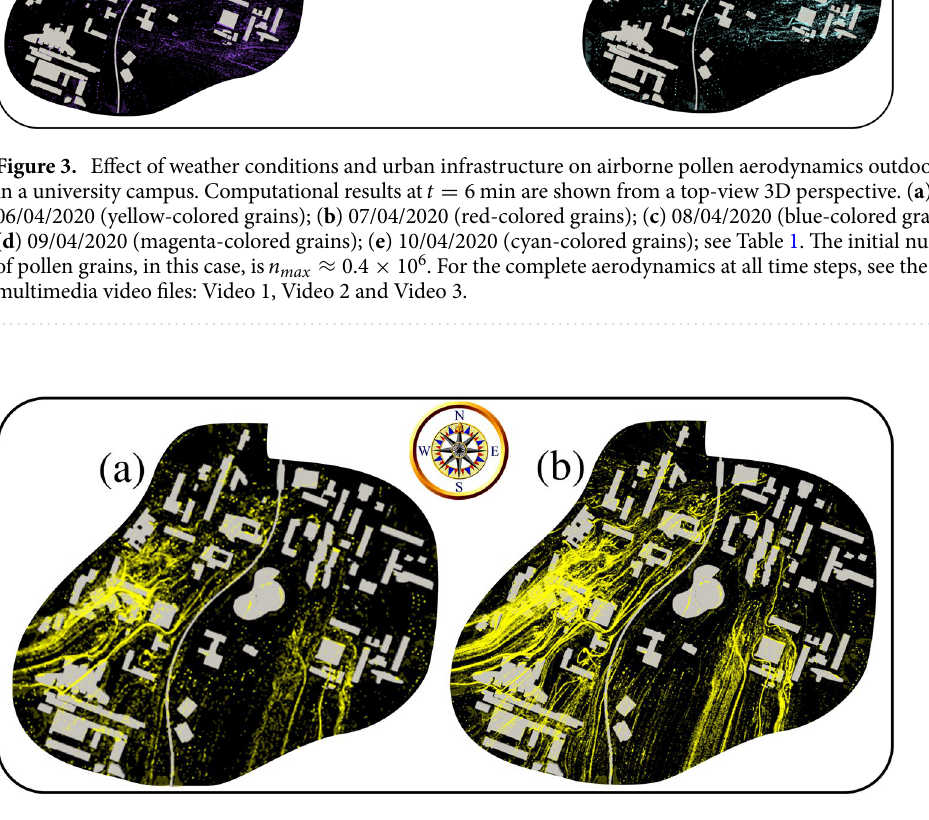
Figure 4. Effect of pollen grains total production or maximum number ( n max ) imposed at t = δτ → 0 + . The case is of the weather conditions on 06/04/2020. Computational results at t = 6 min. ( a ) Domain top view with n max ≈ 0.4 × 10 6 pollen grains; ( b ) domain top view with n max ≈ 4 × 10 6 pollen